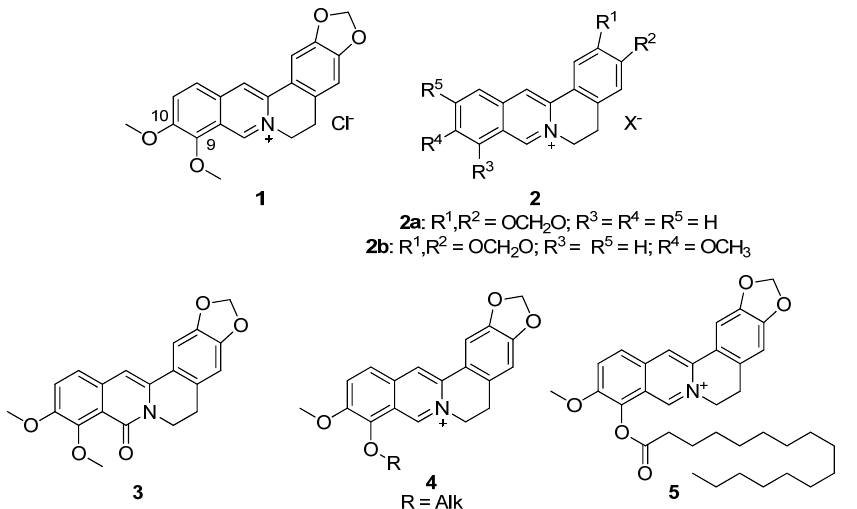
Figure 1. Structures of berberine 1 and its derivatives 2 – 5 , which possessed hypoglycemic activity. The hypoglycemic effect of berberine is very apparent, but the clinical dosage of ber- berine is relatively high (380 mg/kg) [14]. The main reason for that is the oral bioavailabil-